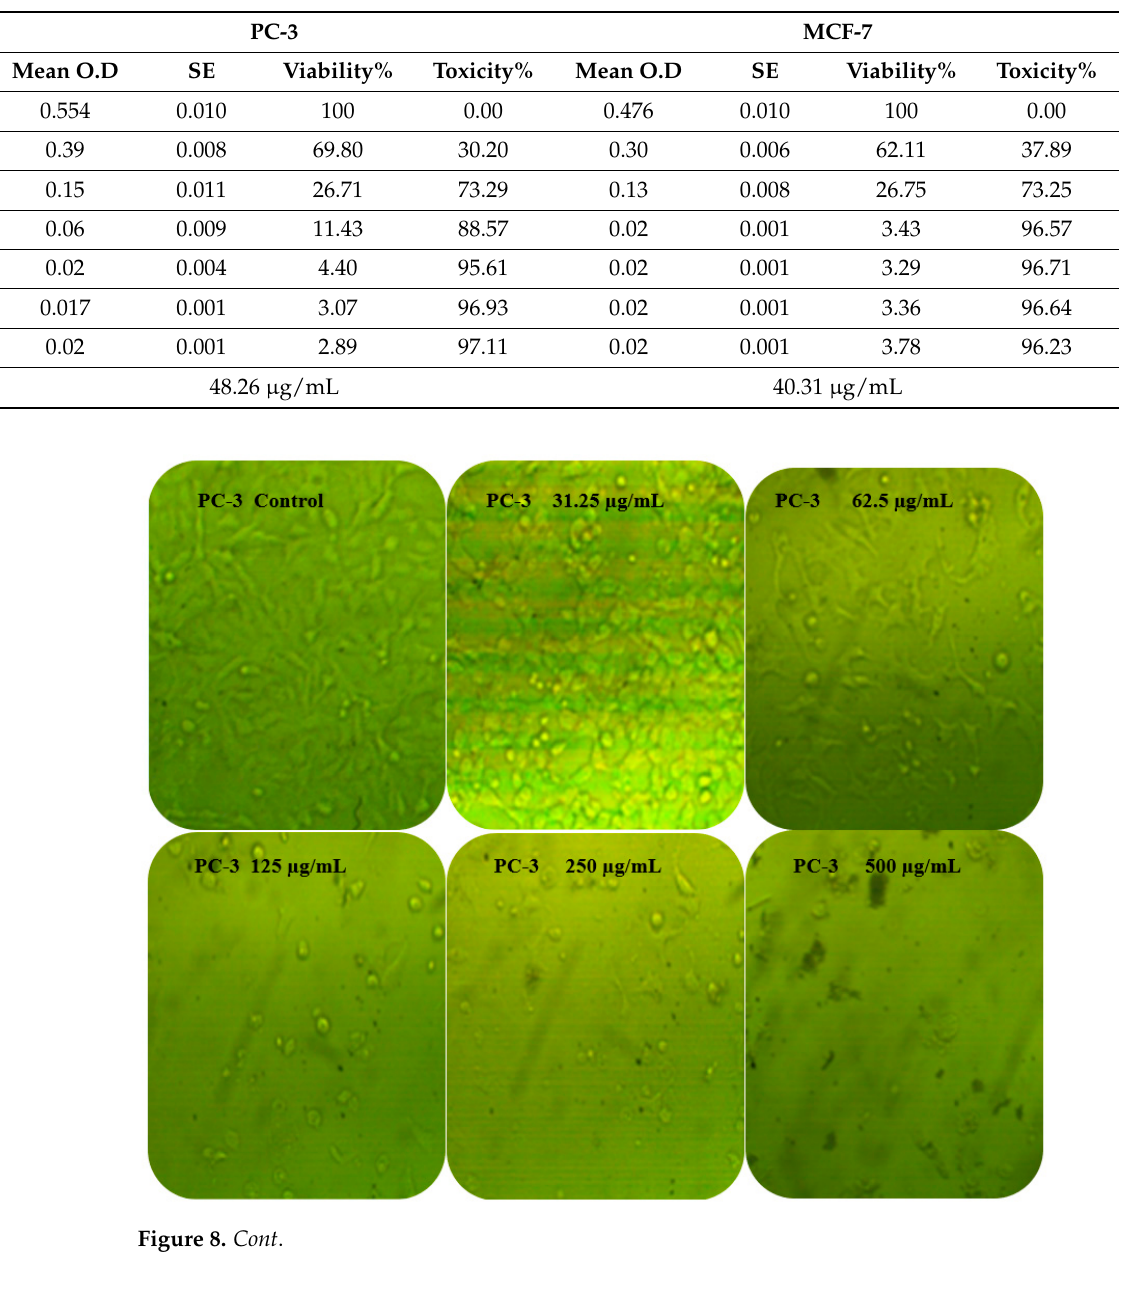
Table 3. Anticancer activity of latex against PC-3 and MCF-7.